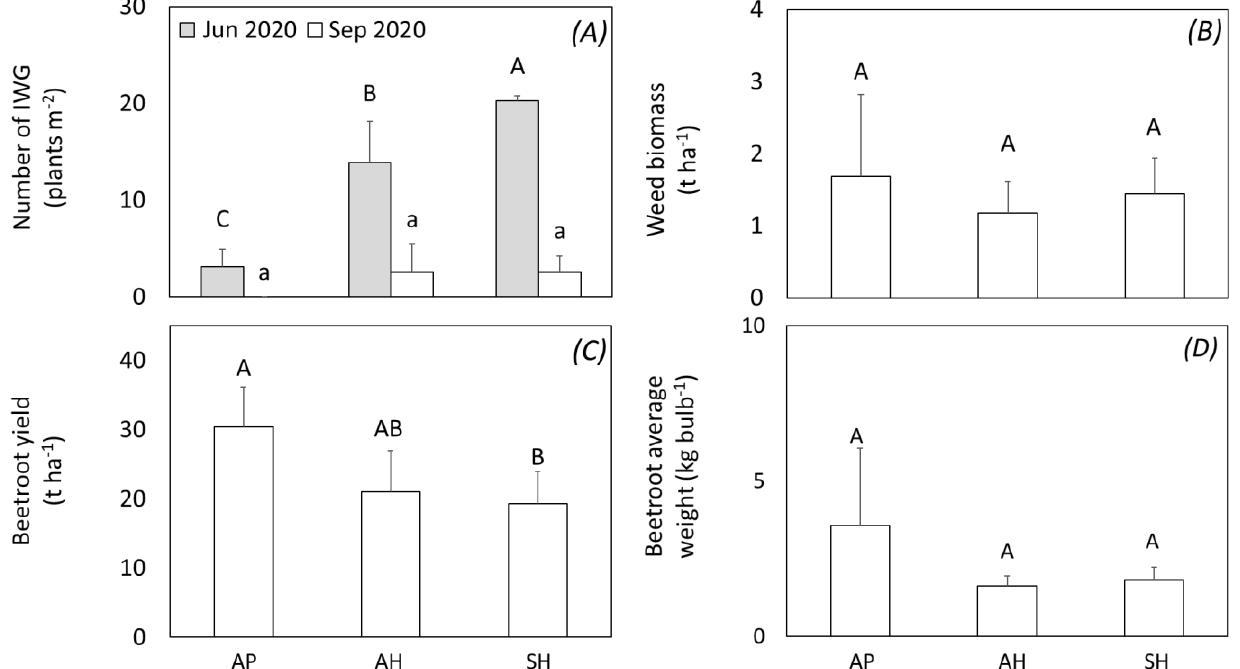
Figure 2. Number of IWG plant individuals per square meter in June and September 2020: ( A ), the weed biomass ( B ), the yield of beetroot ( C ) and average bulb weight ( D ) in September 2020. Data are presented as means (N = 4) with standard error deviations. Different lower-case letters indicate the significant difference in number of IWG in April 2020. Different upper-case letters indicate significant differences in September 2020 between the different strategies for terminating Kernza (AP, autumn ploughed; AH, autumn harrowing; SH, spring harrowing).